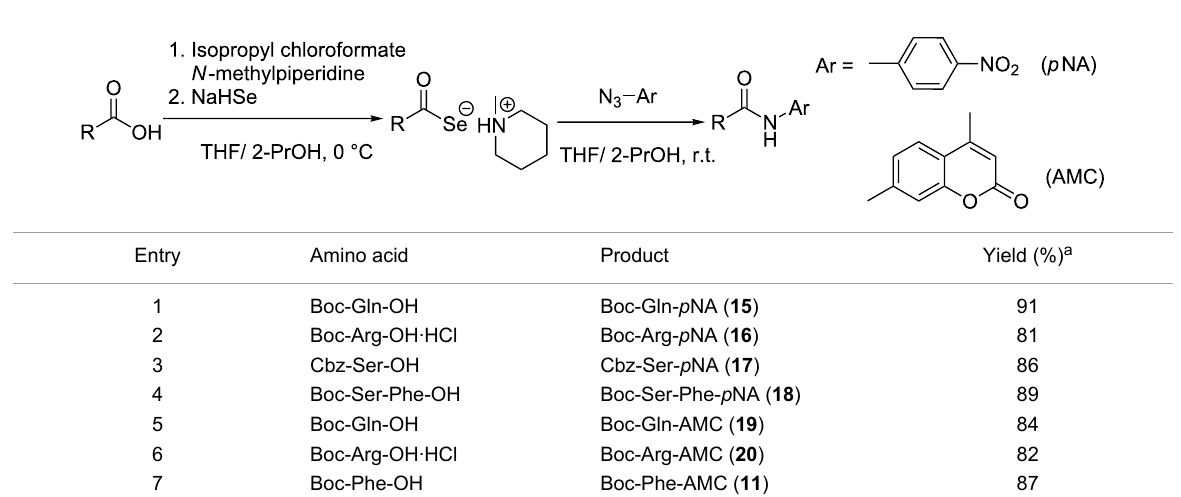
Entry Amino acid Product Yield (%) a 1